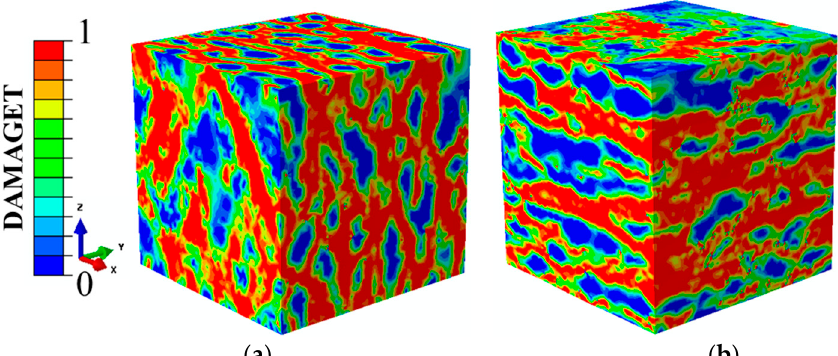
Figure 17. Two failure patterns under compressive-compressive-tensile loadings. ( a ) Y( σ 3 )/f c = 0.21X( σ 1 )/f c = − 0.08; ( b ) Y( σ 3 )/f c = 0.21X( σ 1 )/f c = − 0.25